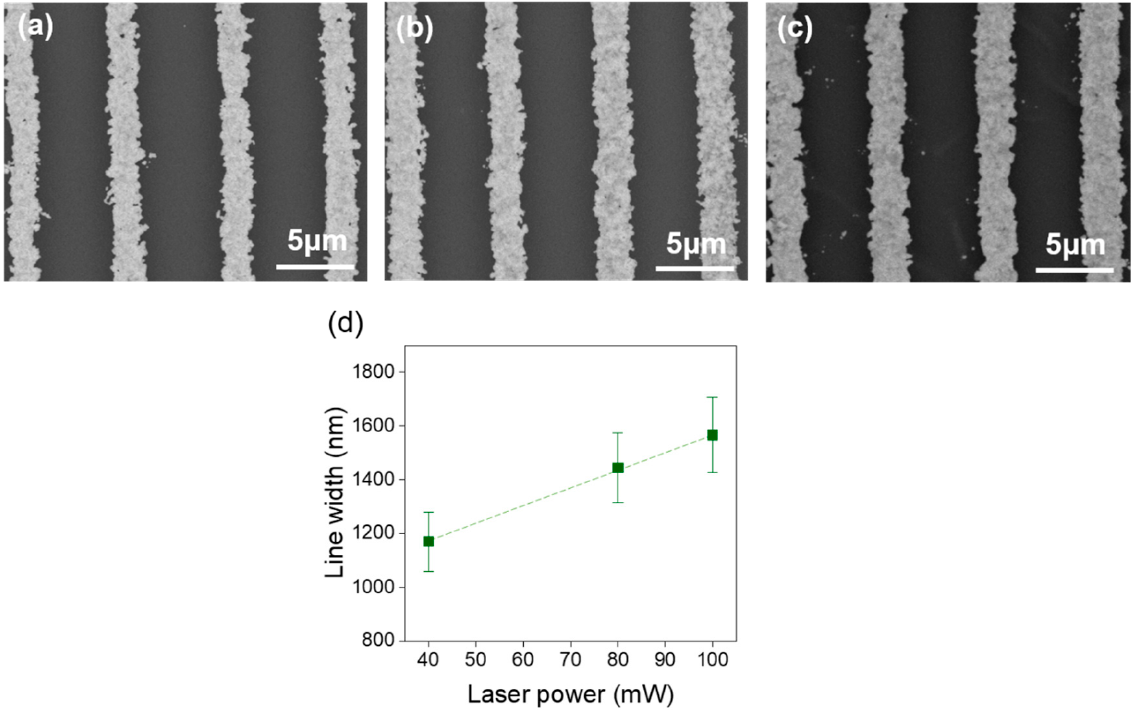
Figure 4. SEM micrographs showing AuNSs fabricated via DLW using an SS = 200 µm/s and an LP of ( a ) 40 mW; ( b ) 60 mW; ( c ) 100 mW. ( d ) Average line width of the different AuNSs printed as a function of the LP.